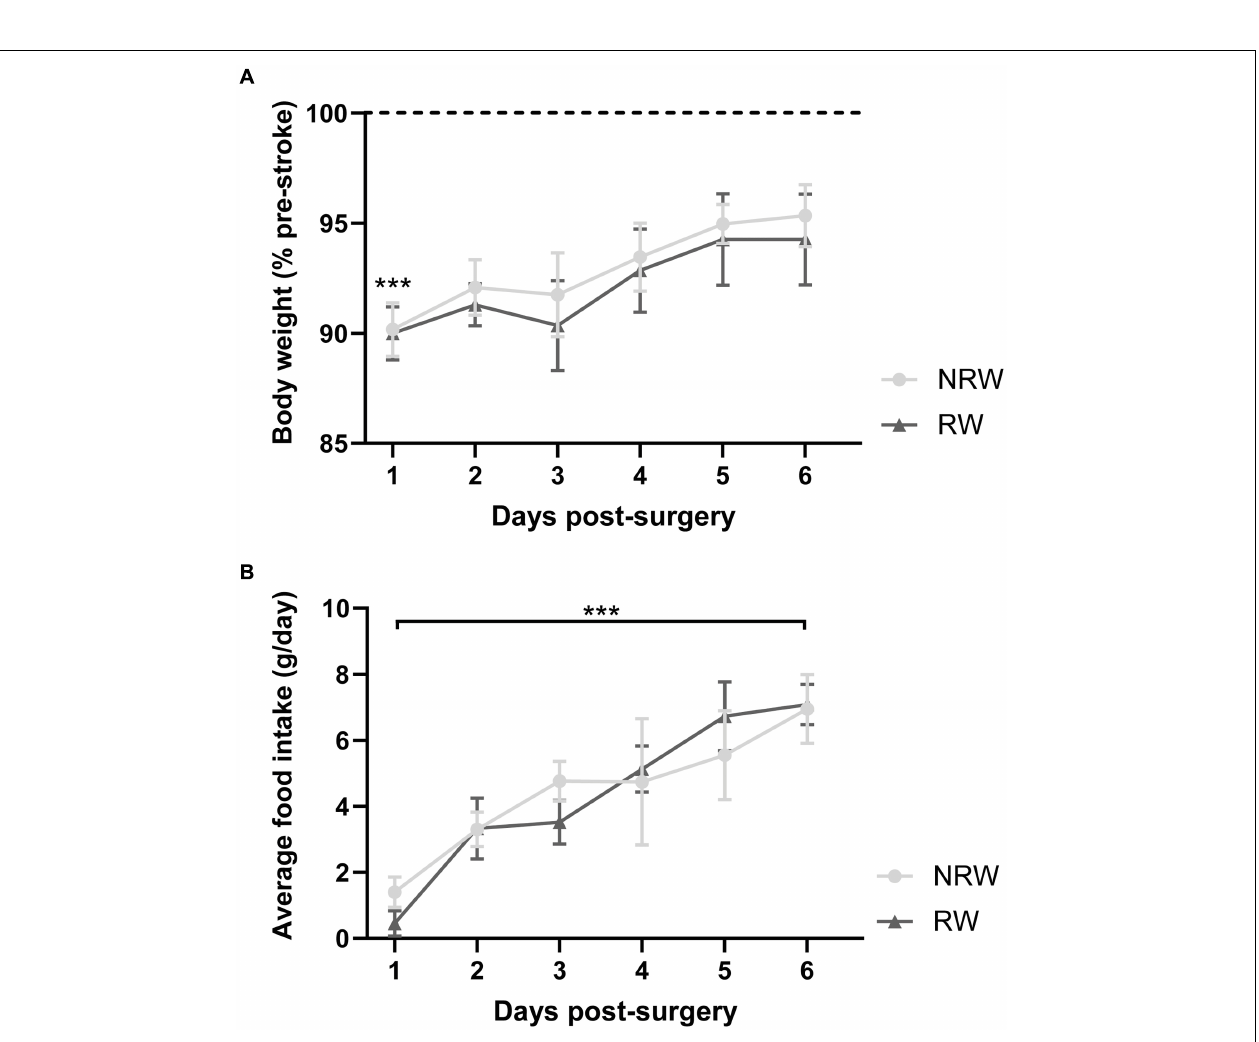
FIGURE 2 | (A) Body weight relative to pre-stroke weight and (B) food intake per day in running wheel (RW) and no running wheel mice (NRW). RW: N = 5, NRW: N = 5; values represented in mean ± SEM. *** p ≤ 0.001.